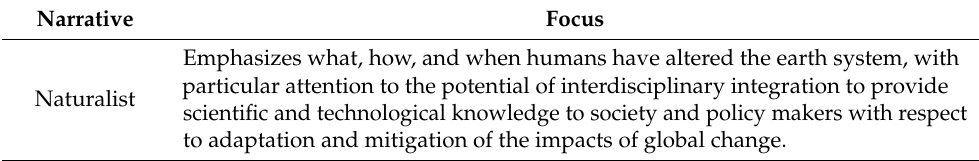
Table 3. Types of narratives around the